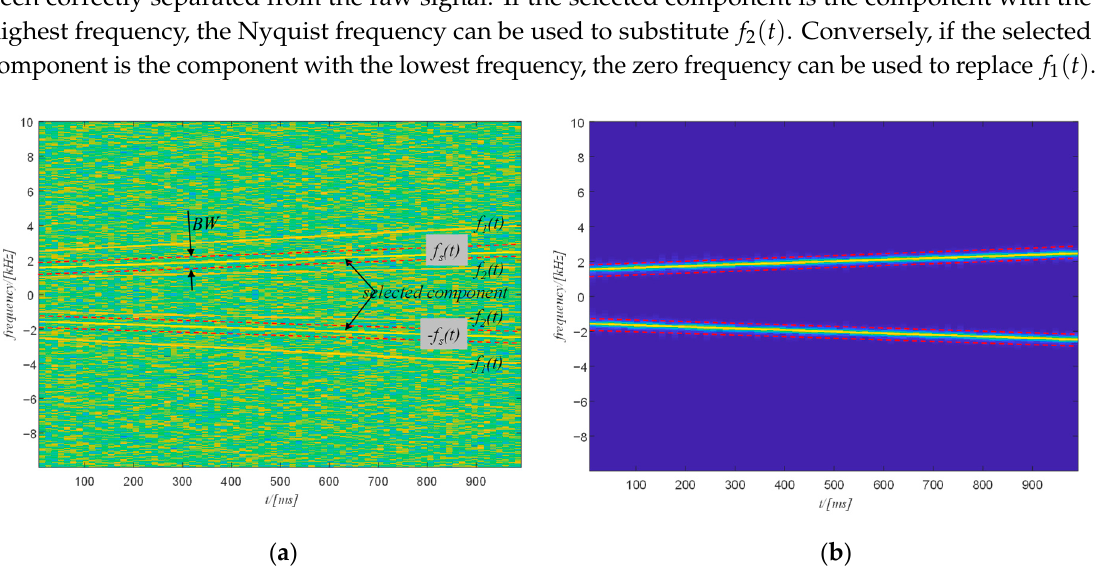
Figure 12. ( a ) The schematic diagram of the filtering; ( b ) the filtered spectrogram.